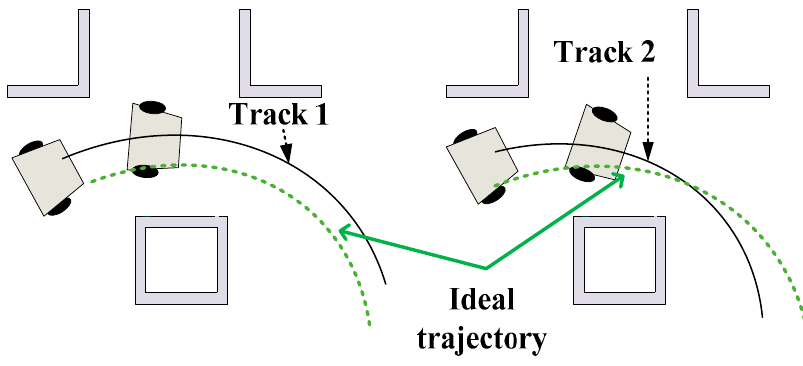
Figure 9. 𝑣𝑒𝑙(𝑣, 𝑤) mechanistic analysis. Figure 9. vel ( v , w ) mechanistic